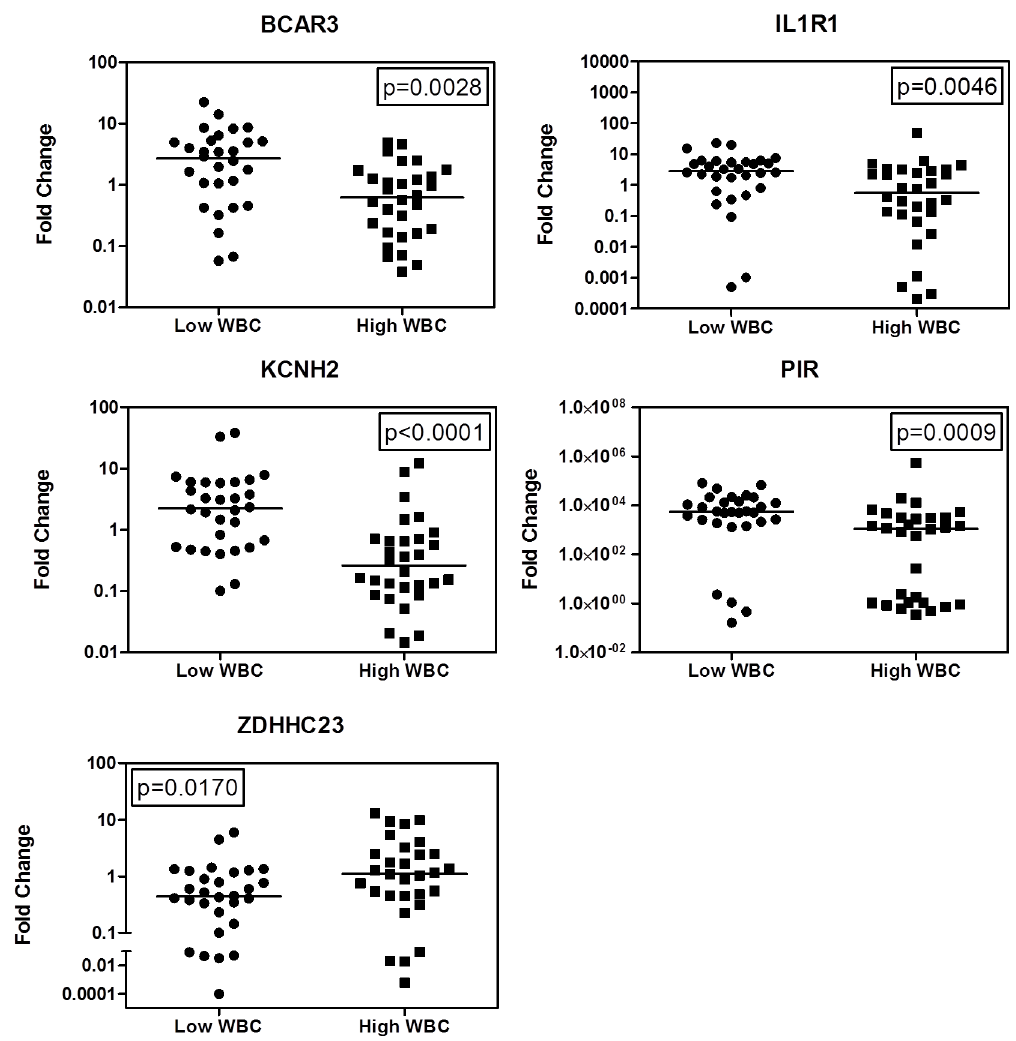
Fig 3. Expression of BCAR3 , IL1R1 , KCNH2 , PIR , and ZDHHC23 were significantly different between the low and high WBC ETV6-RUNX1 -negative patient samples. Total RNAs from ETV6-RUNX1 -negative patient samples were isolated. cDNA was prepared using 1 μ g total RNA and transcript levels were determined by real-time RT-PCR. Transcript levels were normalized to RPL13a and relative expression levels were calculated using the comparative Ct method (comparing all samples to the expression levels in the ETV6-RUNX1 -positive REH cell line). The horizontal lines indicate the median. The P -values were calculated using the Mann-Whitney U -test and GraphPad Prism 5.0